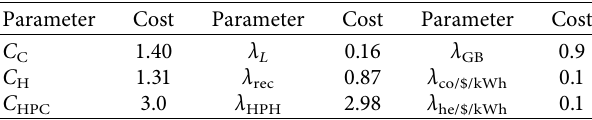
Table 3: Parameter of MG